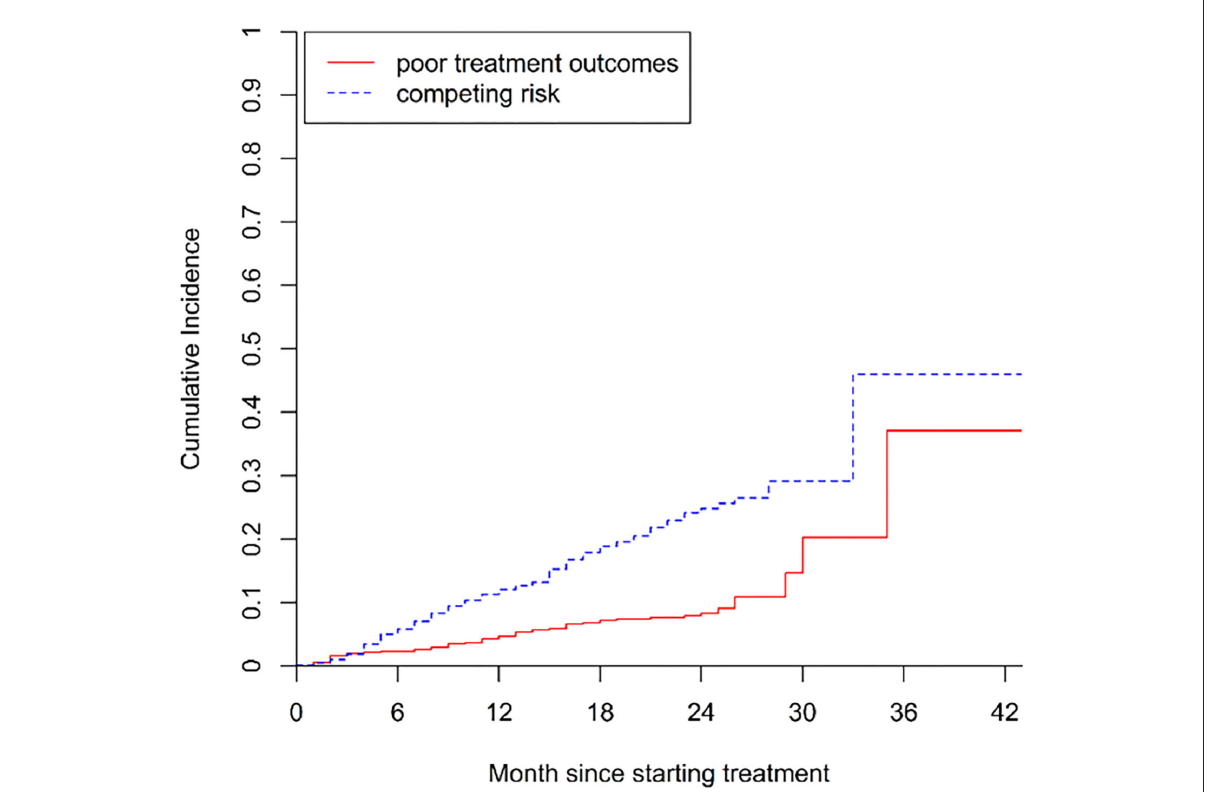
FIGURE2 Cumulative incidence of poor treatment outcomes (i.e., treatment failure and death) in patients with drug-resistant tuberculosis in Guangzhou, China, from 2016 to